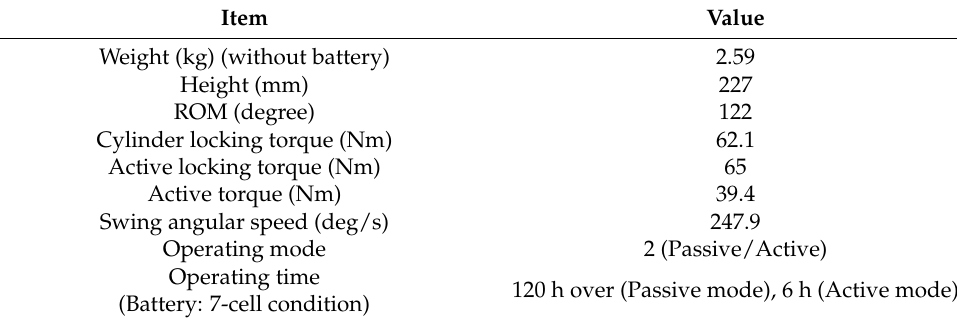
Table 4. Mechanical and electrical characteristics of powered